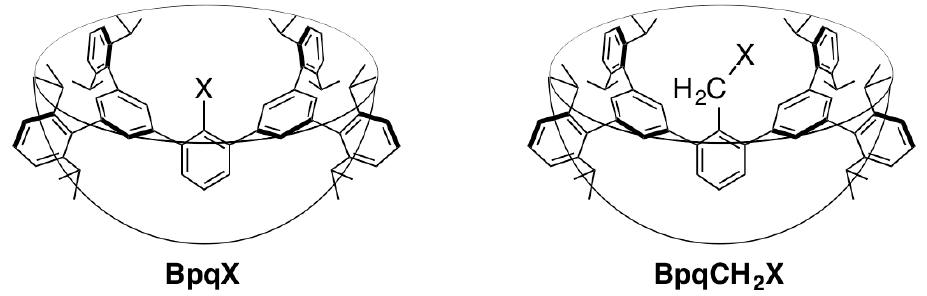
Figure 1. Molecular cavities utilized for the present model study.